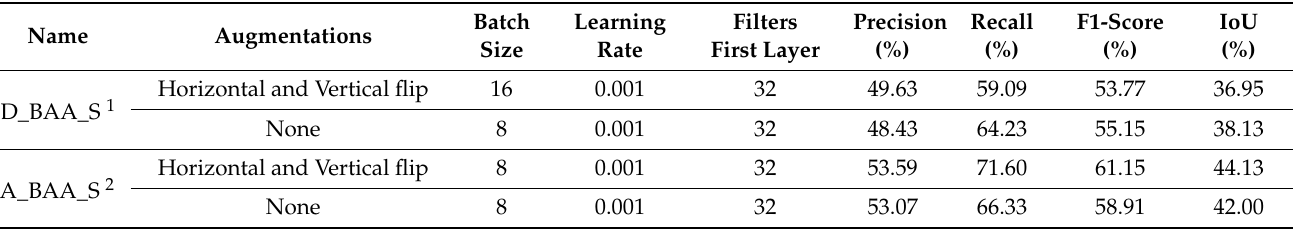
Table 5. Performances and best hyperparameters for Attn-U-Net and BAA_S datasets, with and without